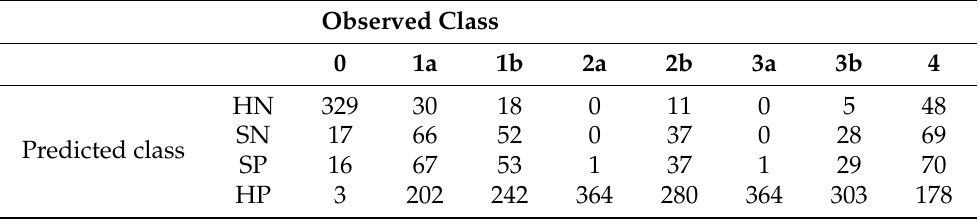
Table 17. Confusion matrix for the validation set and the SVM model. One-class classification.